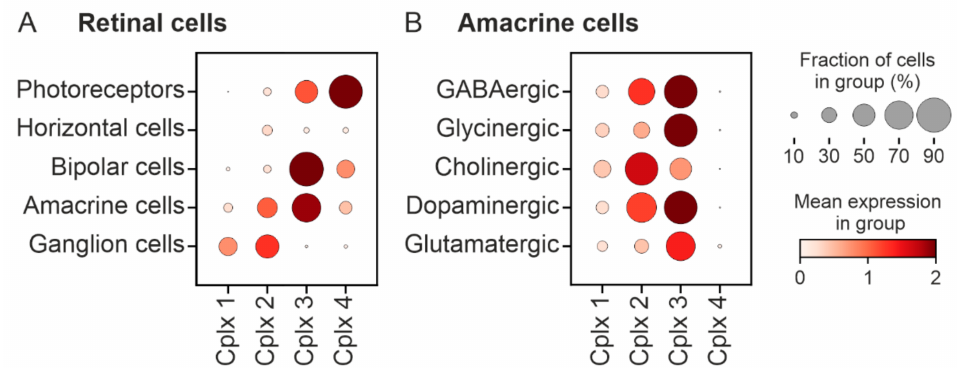
Figure 10. Bioinformatics analysis of the expression of cplx 1 to 4 in cells of mouse retinae. ( A , B ) Clustering according to cell types ( A ) and neurotransmitter types ( B ). Visualized data are based on scRNA-seq data sets [38] ( A ) and [20] ( B